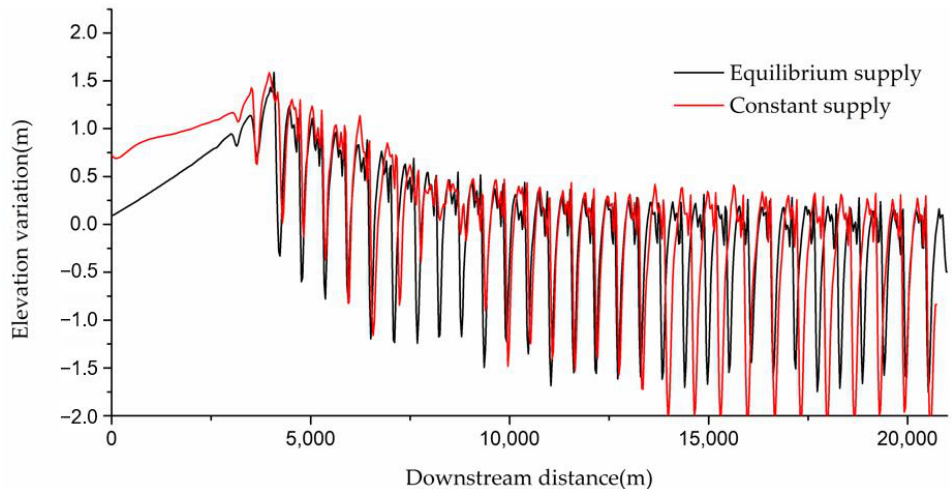
Figure 8. Elevation variation comparison at the right bank in both runs after 1800 h removed phase difference.